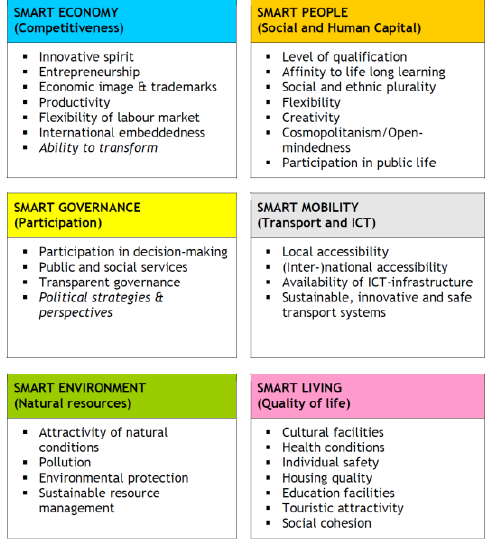
Figure 2. Smart city indicators (SCI): characteristics and factors. Reprinted with permission from ref. [23]. Copyright 2007 SRF-Centre of Regional Science.